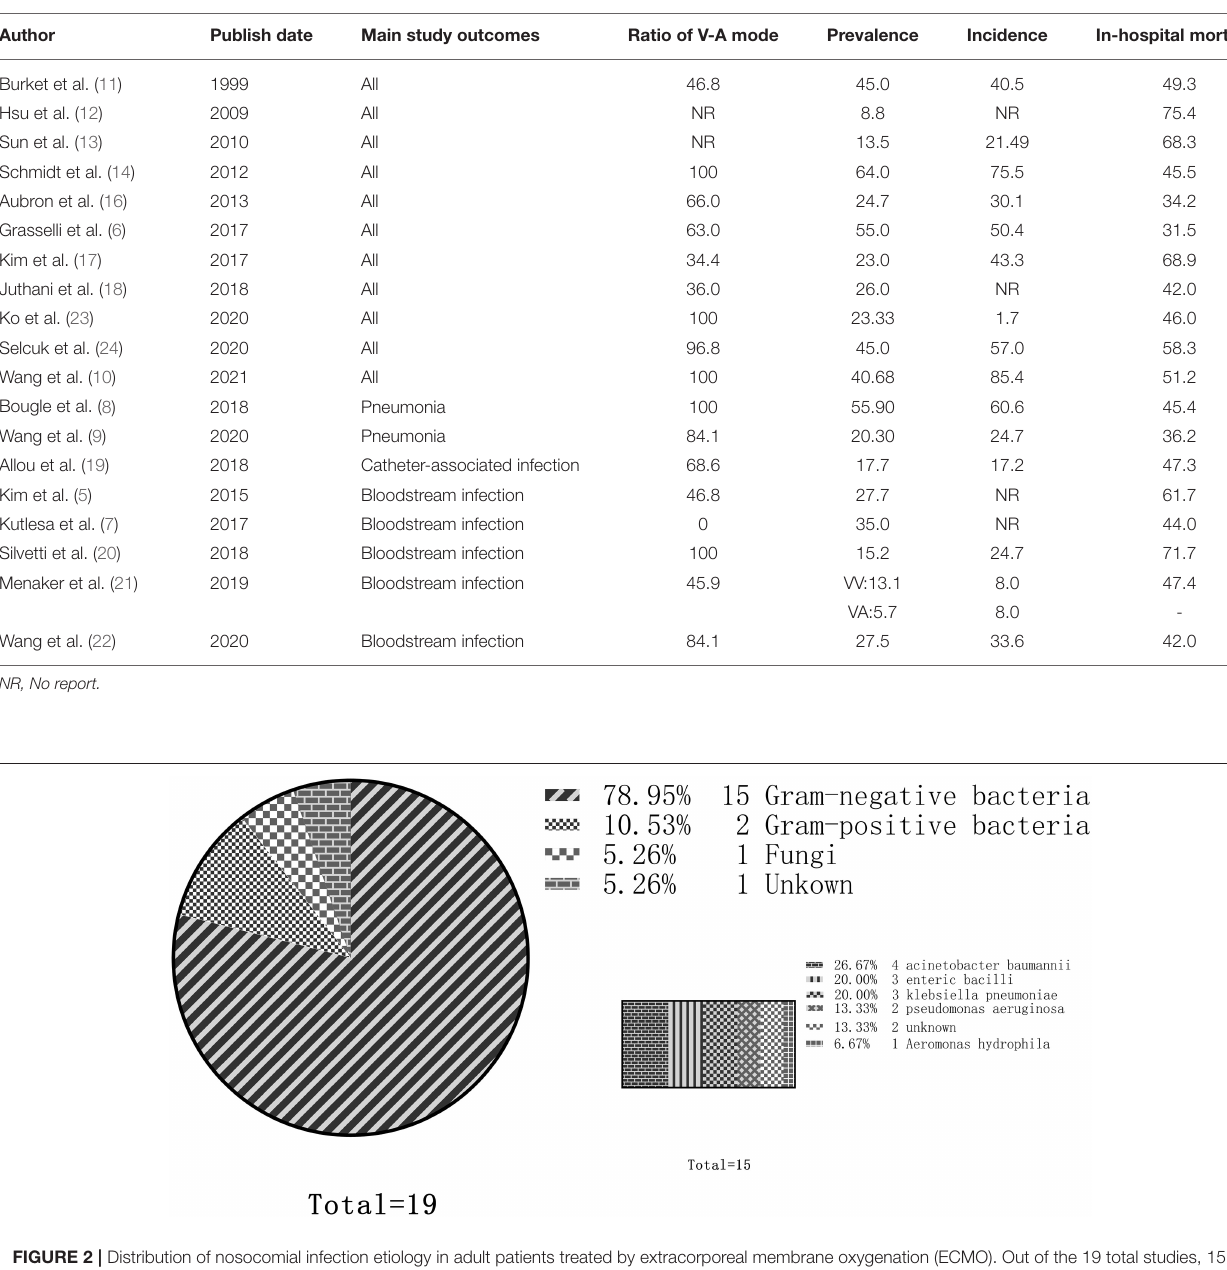
TABLE 3 | Review table of prevalence, incidence, and mortality of nosocomial infection in patients receiving extracorporeal membrane oxygenation (ECMO).